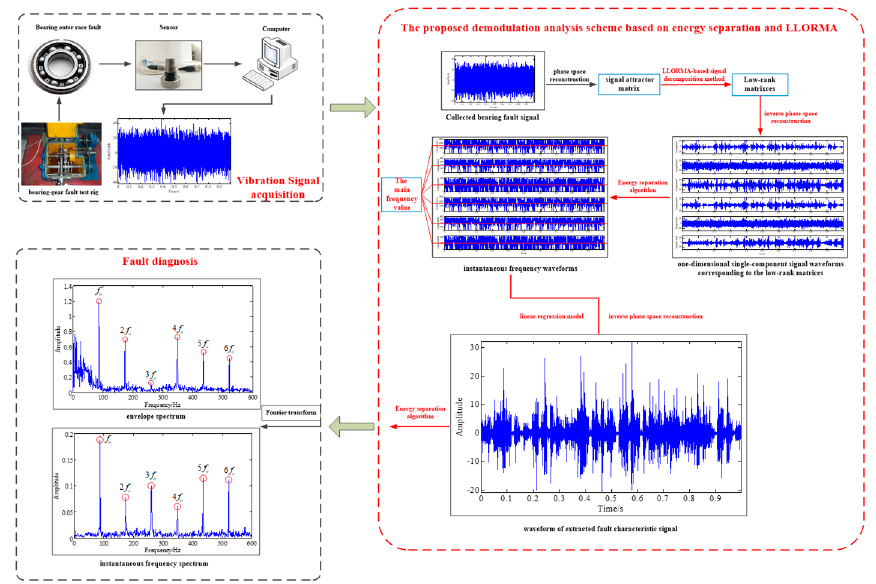
Figure 7. Flowchart of the proposed novel demodulation analysis technique based on energy separation and LLORMA.